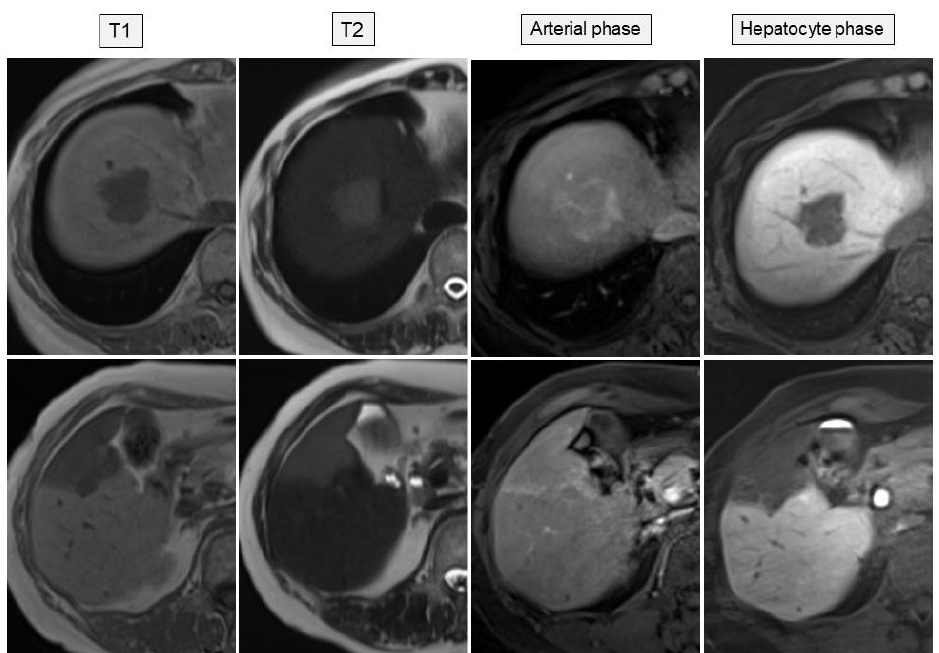
Figure 4. Gd-EOB-DTPA-enhanced magnetic resonance imaging visualized the lesions at segments S8 (upper panel) and S5 (lower panel) in the liver as low-intensity lesions in T1-weighted images, high-intensity lesions in T2-weighted images, ring-enhancement pattern lesions in the arterial phase, and mainly low intensity lesions in the hepatobiliary phase.